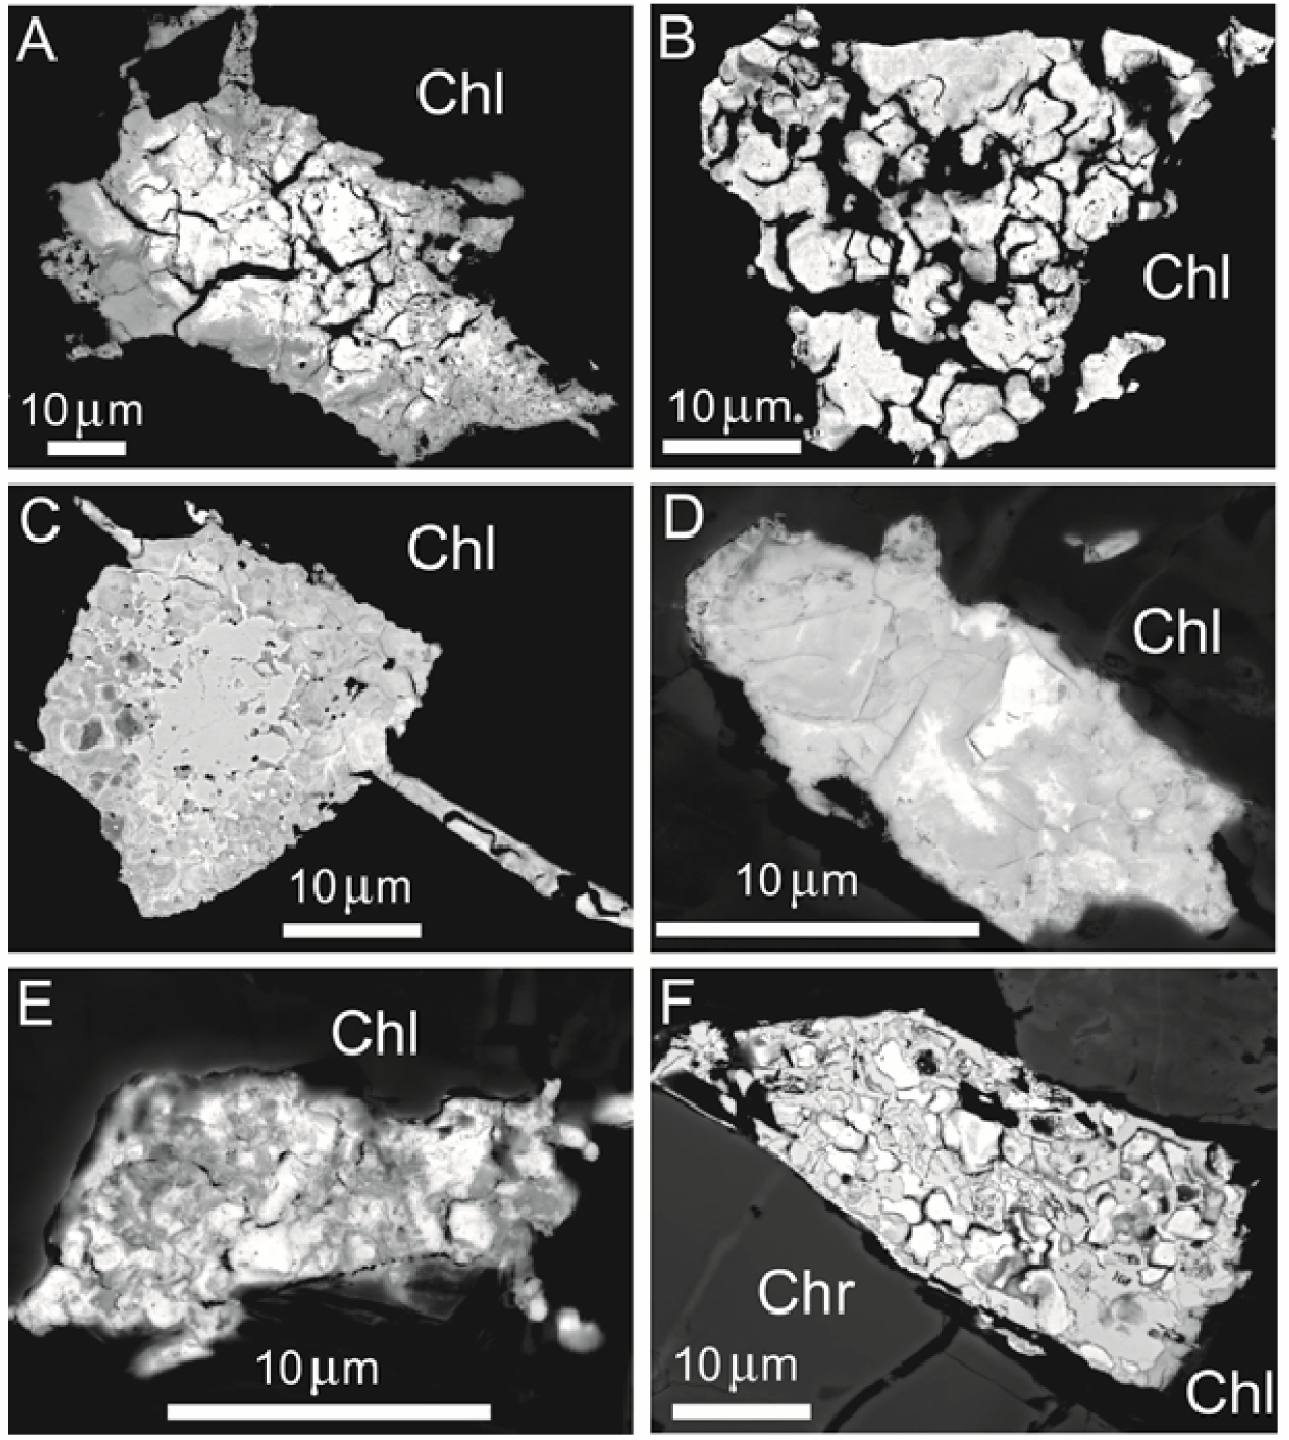
Figure 18. FE-SEM images of Pt-bearing alloys found in high-Al chromitite of Sebuku Island revealing a porous texture, irregular shape and zoning, enclosed in chlorite ( A – E ) and in the contact of chromite and chlorite ( F ). Abbreviations: Chr—chromite,